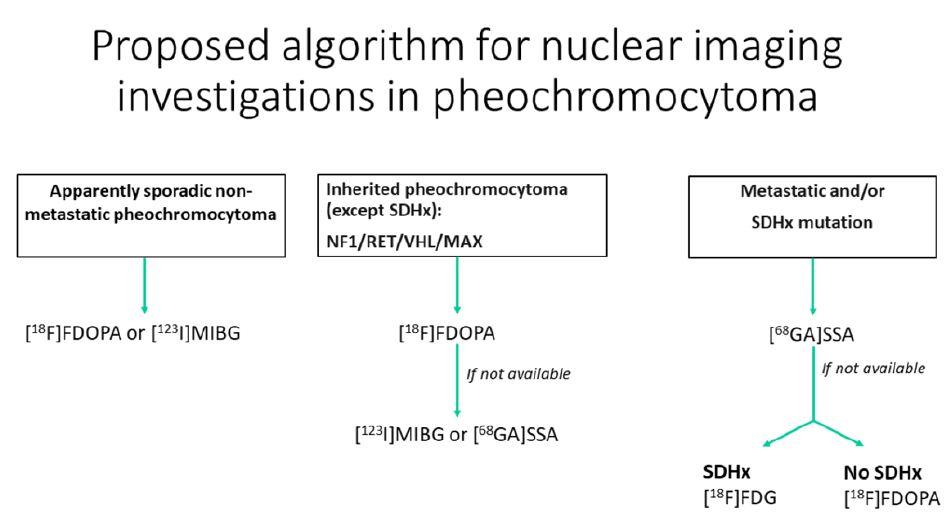
Figure 8. Diagram of the algorithmic approach for the appropriate use of nuclear medicine when adrenal pheochromocytoma is suspected (adapted from Taieb et al. [71]). 18 F-DOPA, 18 F-fluoro-labeled fluorodopamine; 123 I-MIBG, 123- iodine-labeled meta-iodobenzylguanidine; 68 GA-DOTA-SSA, 68-gallium labeled DOTA somato- statin analogs; SDHx, succinate dehydrogenase Type x; NF1, neurofibromatosis